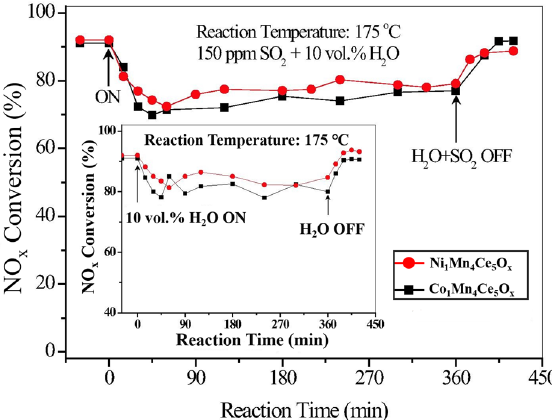
Figure 16. The resistance to H 2 O and/or SO 2 over Co 1 Mn 4 Ce 5 O x and Ni 1 Mn 4 Ce 5 O x (Reaction conditions: [NO] = [NH 3 ] = 500 ppm, [O 2 ] = 5 vol%, [SO 2 ] = 150 ppm, [H 2 O] = 10 vol%, N 2 to balance, total flow rate = 200 mL/min, GHSV = 48,000 h − 1 ). (Reproduced with permission from Reference [39], Copyright 2017, Elsevier.). Catalysts 2018 , 8 , 11